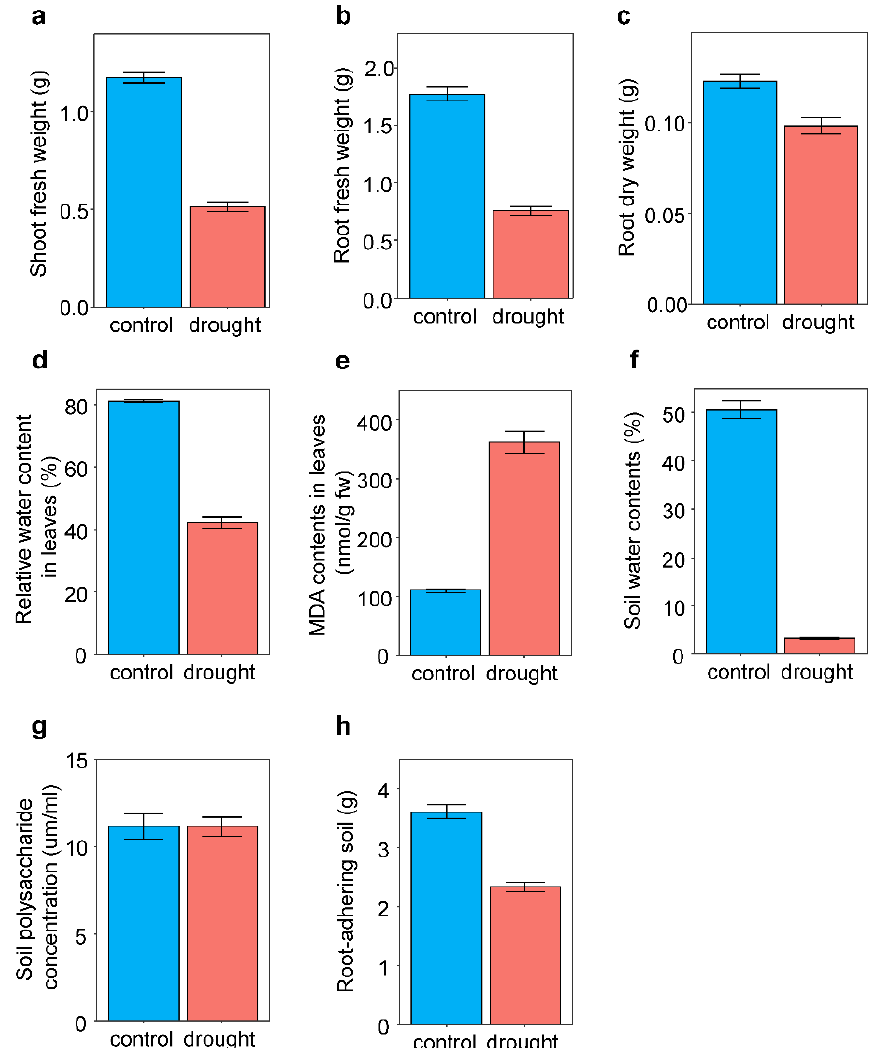
Figure 1. Effects of drought treatment on plant traits and soil characteristics Average values and standard errors of ( a ) shoot fresh weight, ( b ) root fresh weight, ( c ) root dry weight, ( d ) relative water content in leaves, ( e ) MDA contents in leaves, ( f ) soil water contents, ( g ) soil polysaccharide concentration, and ( h ) root-adhering soil are given.